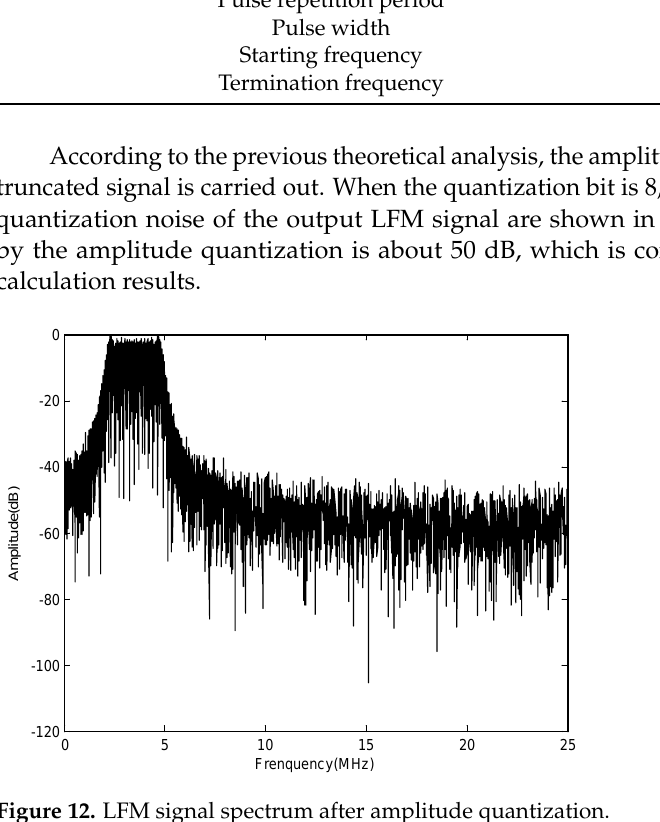
Figure 12. LFM signal spectrum after amplitude quantization.